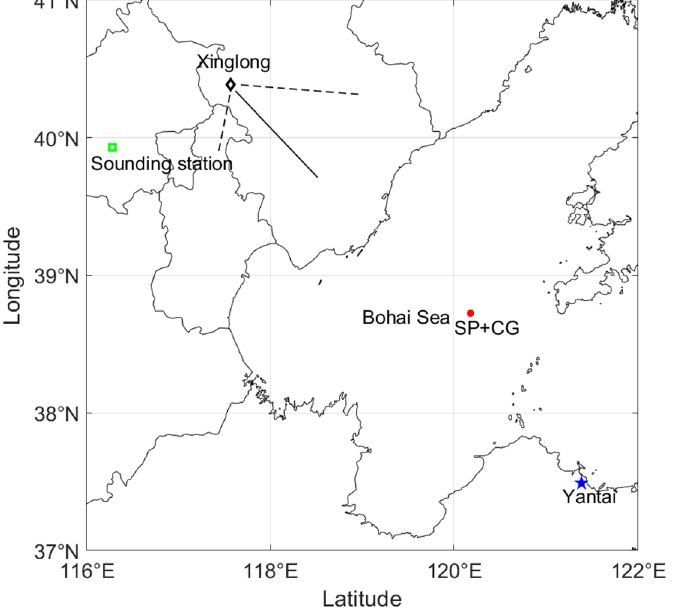
Figure 1. Overview of observation points. The location of the camera at the Xinglong Observatory is indicated by a black diamond, the Yantai radar station is marked by a blue star, and the Beijing sounding station is marked by a green square. The black line is the sprite azimuth. The two dashed lines are the camera’s field of view.